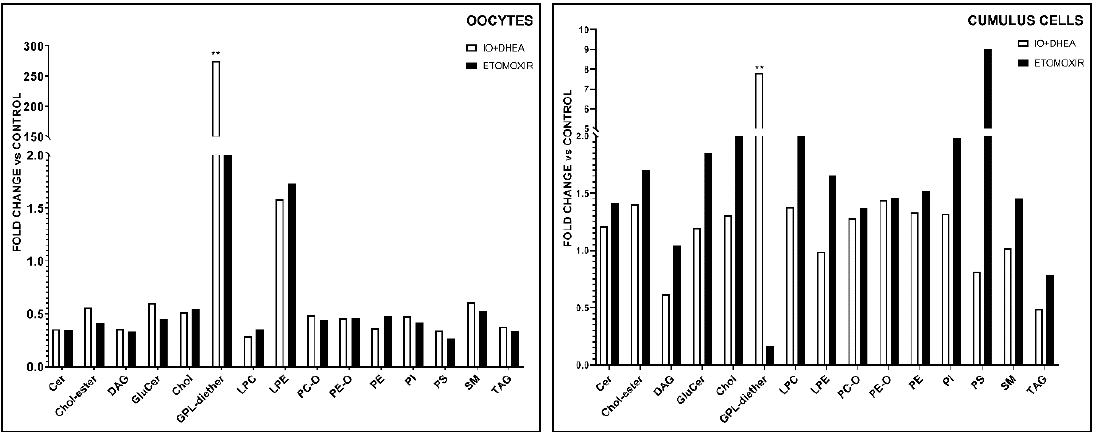
Figure 8. The effect of glucose (IO+DHEA) and fatty acid (ETOMOXIR) metabolism inhibition on the lipidome in oocytes and cumulus cells. The results are shown as a fold change relative to the control group (means of experimental groups divided by means of control group). ** — p ≤ 0.01. Cer (ceramides); Chol-ester (cholesterylester); DAG (diacylglycerols); GluCer (glucosylceramide); Chol (cholfragment); LPC (lysoPhosphatidylcholine); LPE (lysoPhosphatidylethanolamine); PC-O (phosphatidylcholineether); PE-O (phosphatidylethanolamineether); PE (phosphatidylethanolamine); PI (phosphatidylinositol); PS (phosphatidylserine); SM (sphingomyelin); TAG (triacylglycerol).